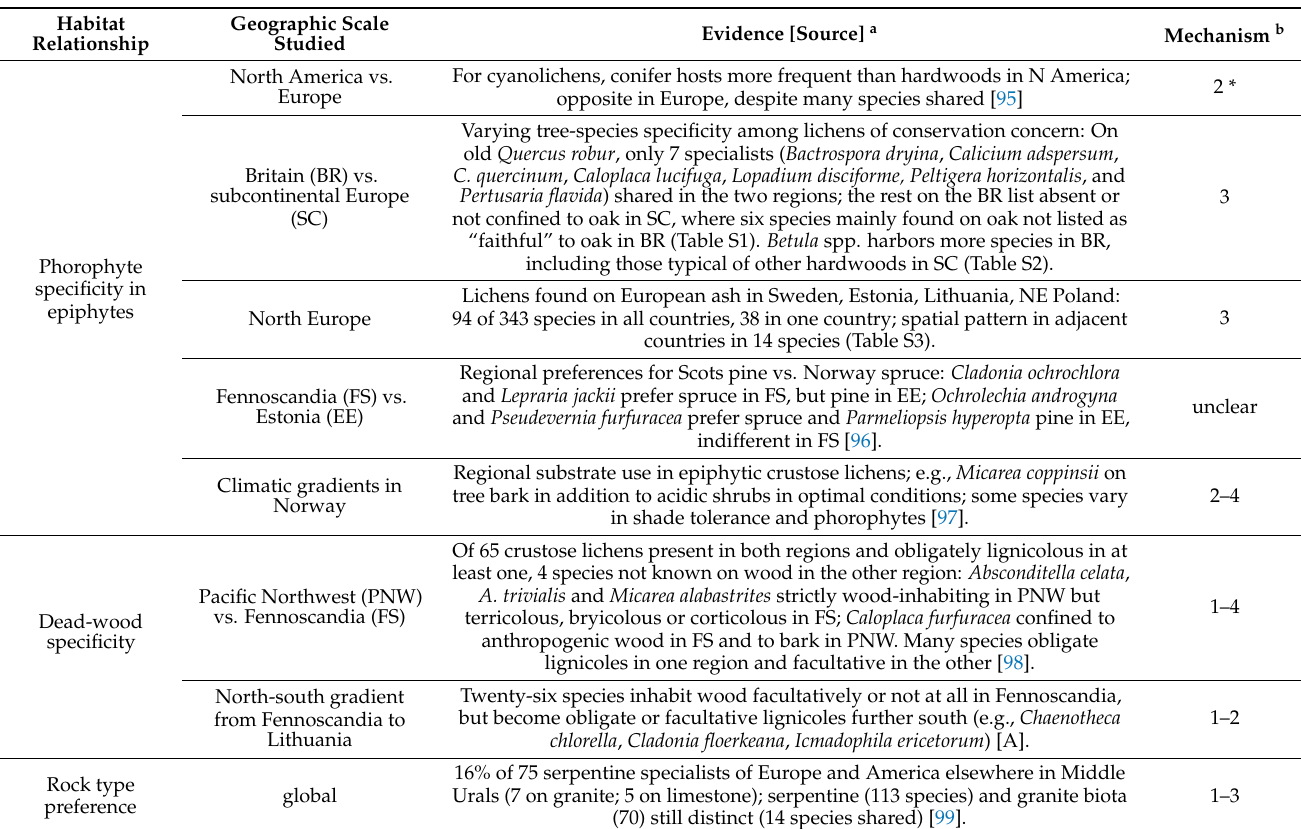
Table 1. Examples of geographically varying habitat preferences of lichens in the cases where different habitat availability has been accounted for or can be assumed. See [50,51] for a collection of earlier observations, notably on shifts in substrate